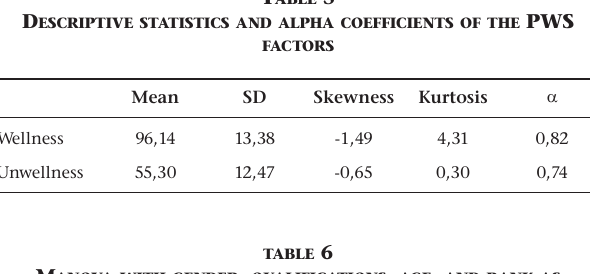
table 6 m anova with gender , qualifications , age , and rank